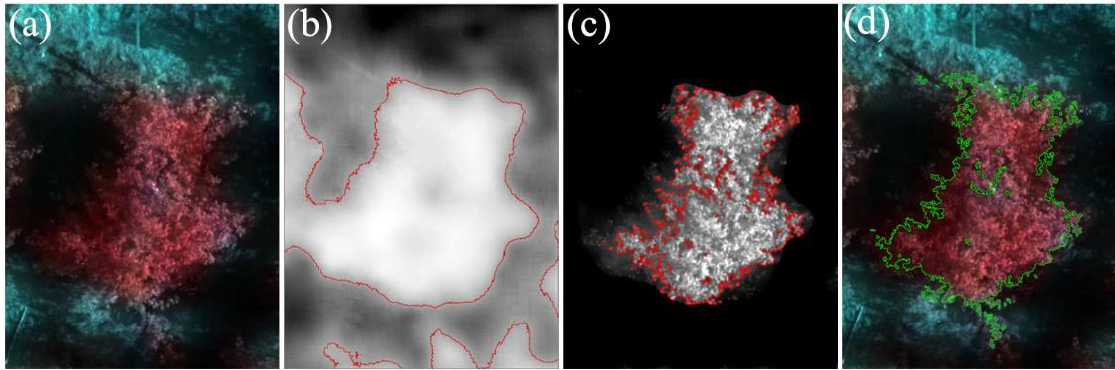
Figure 2. Canopy extraction map of apple: ( a ) Original image standard false color synthesis (R 768 ,R 688 ,R 628 ); ( b ) NDVI 0.65; ( c ) NDCSI 0.45; ( d ) Canopy extraction via RFC.